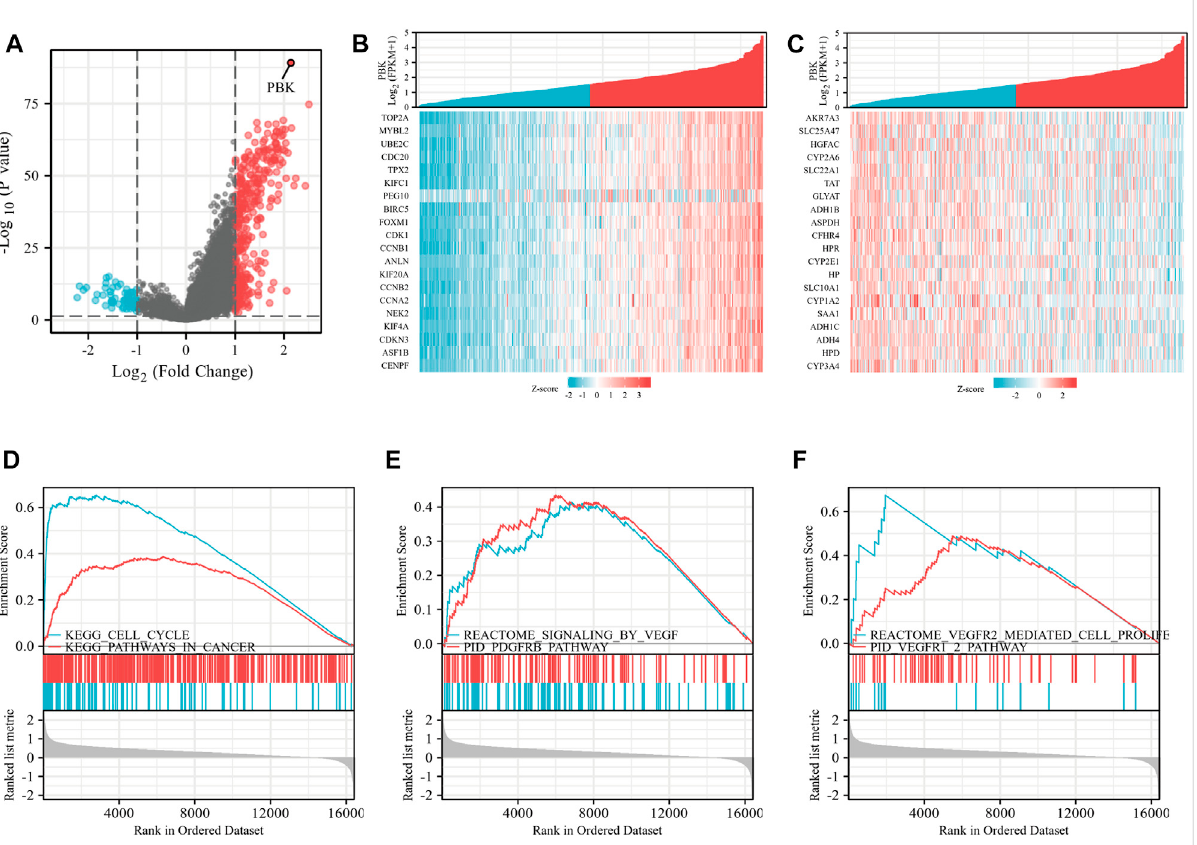
FIGURE 7 PBK -related differential gene and pathway enrichment. (A) Volcano maps were made according to the PBK -related differential genes. (B) Heatmap of the top 20 up-regulated genes. (C) The top 20 up-regulated genes were screened. (D – F) GSEA analysis based on the